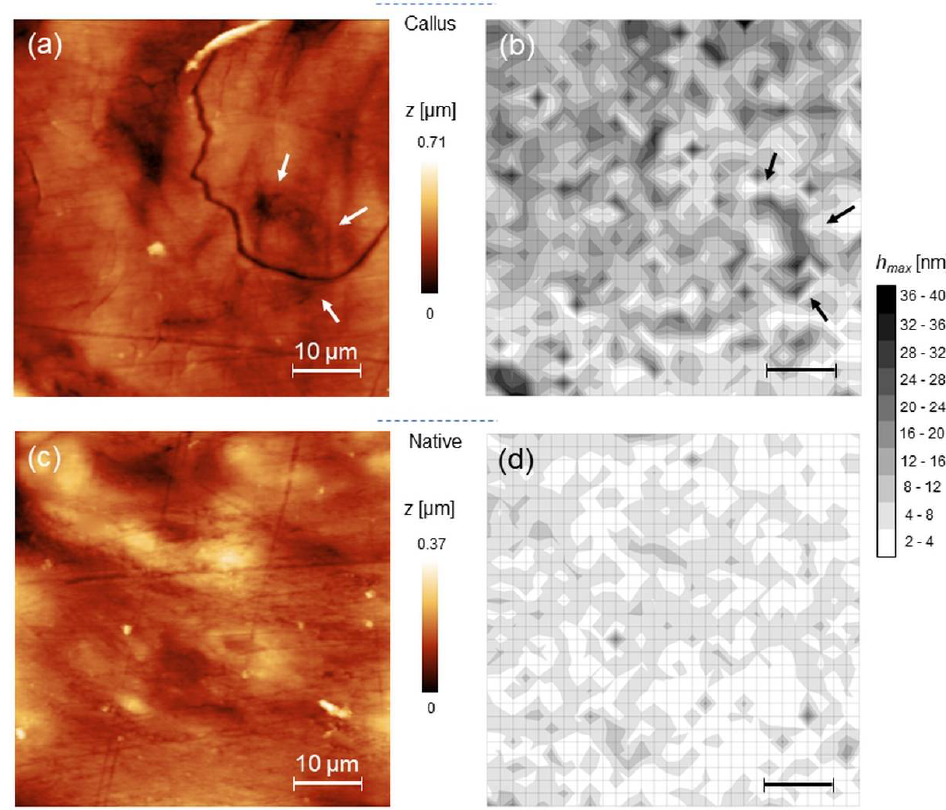
Figure 3. ( a ) representative 50 × 50 µm 2 AFM topography of bone callus and the corresponding map of h max ( b ); ( c , d ) the same as ( a , b ) for native bone. The Young’s moduli maps obtained according to spherical-modified Hertz and Oli- ver–Pharr models are reported, together with the corresponding ηel maps. (Figure 4). Qualitatively, an increase in moduli from callus to native is observed, as expected by the corresponding variation of hmax observed in the previous figure. Yet, from the ηel maps one notes that both callus and native regions exhibit prevalently elastic character (preva- lence of white in Figure 4c,f). To make these considerations quantitative, values corre- sponding to 25th, 50th and 75th percentiles of the non-parametric distributions of hmax, ηel and Young’s moduli are reported (Table 1).